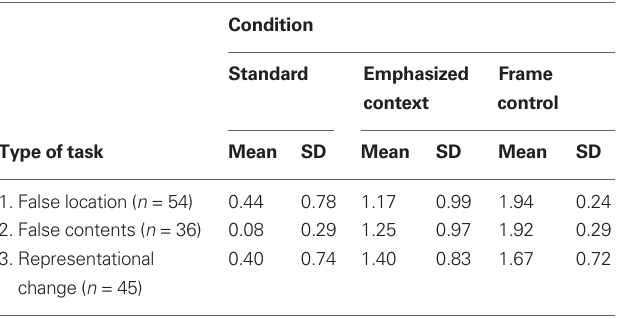
Table 1 | Mean number of correct answers out of 2 to test questions in task 1 to